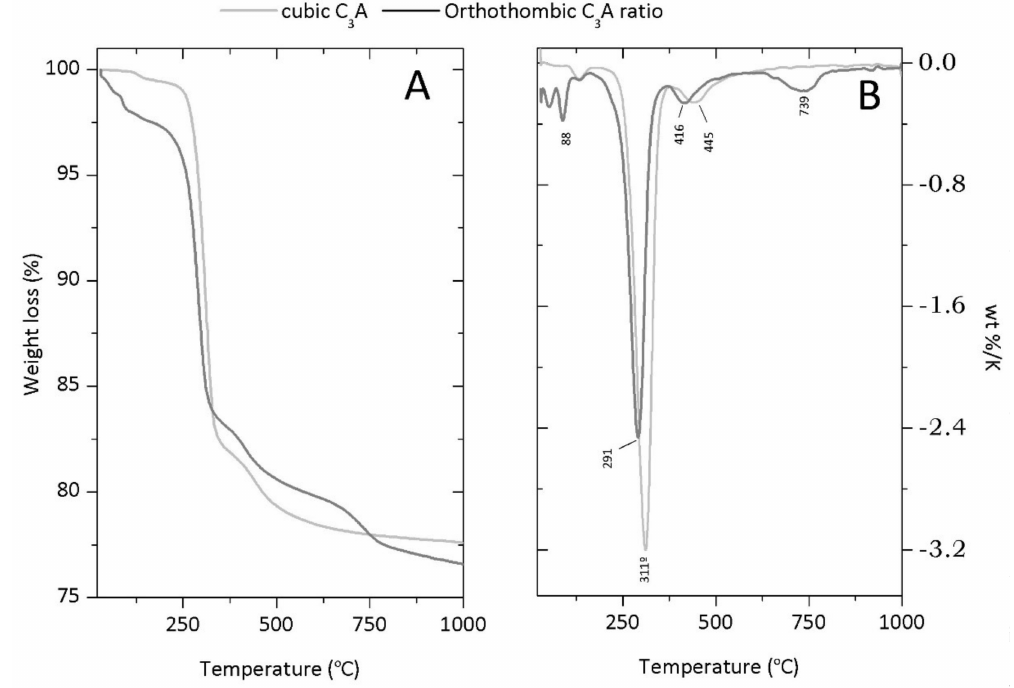
Figure A1. Weight loss curve profiles determined by ( A ) TGA and ( B ) DTG of hydrated pastes of Cubic and Orthorhombic samples without gypsum after three